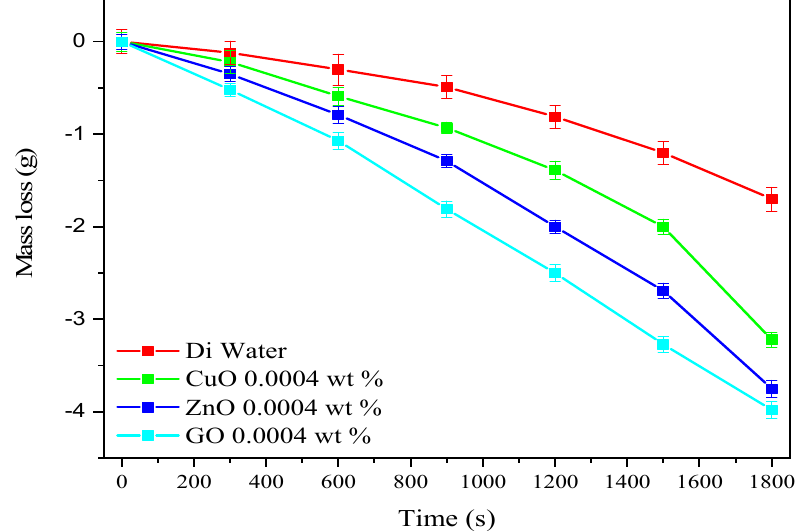
Figure 8. Mass loss for a specific time duration in nanofluid of CuO, ZnO, and GO under natural sun over the period of 1800 s of DI water base nanofluids at 0.0004 wt % concentration.